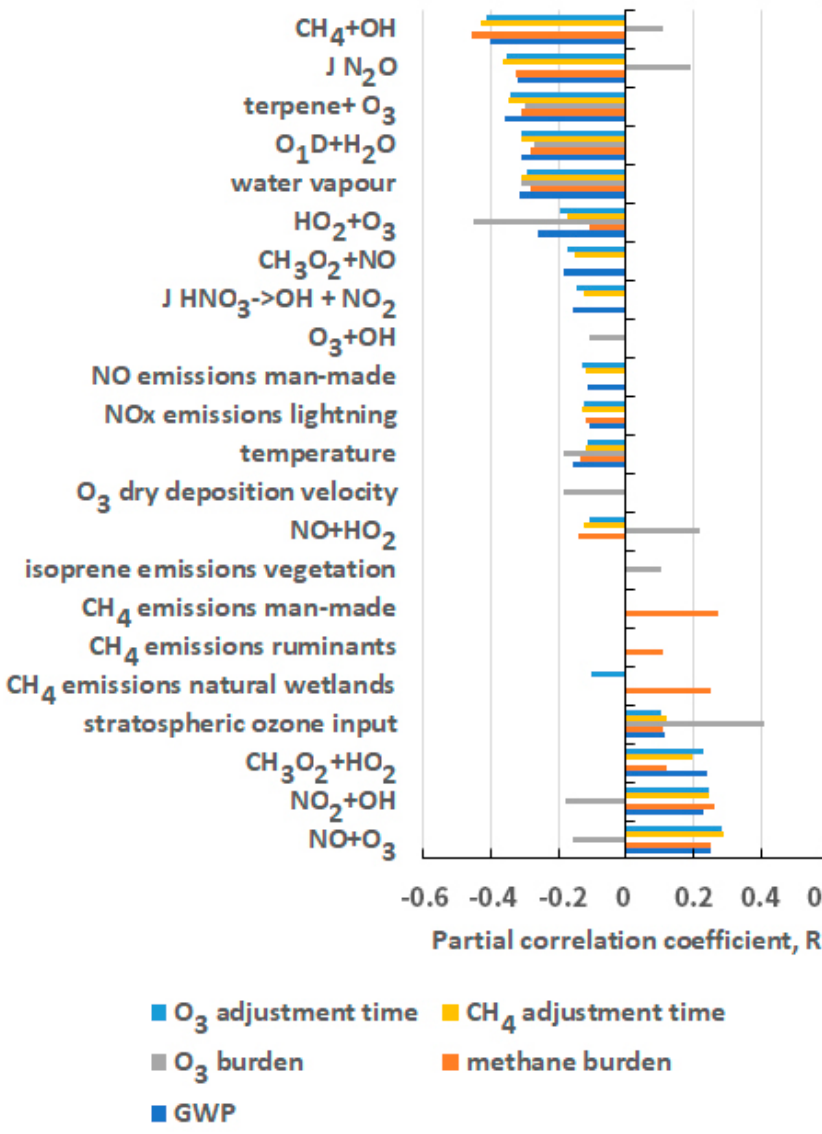
Figure 3. Partial correlation coe ffi cients from the multiple linear regression analyses of the adjustment times, burdens and the resulting GWP for CH 4 on the 183 uncertain model input